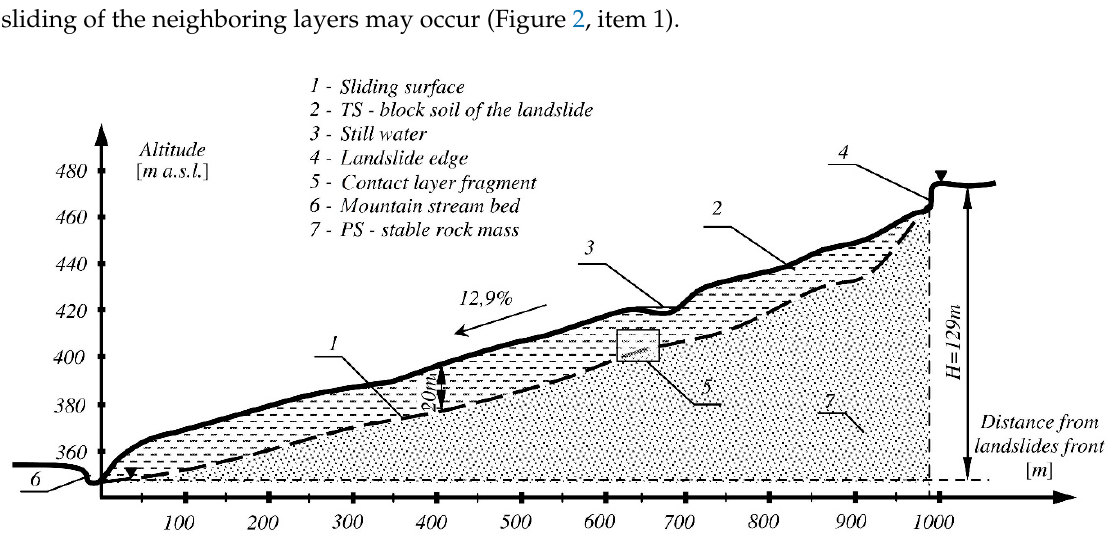
Figure 2. Cross-section of the landslide (Zapadle, Poland).